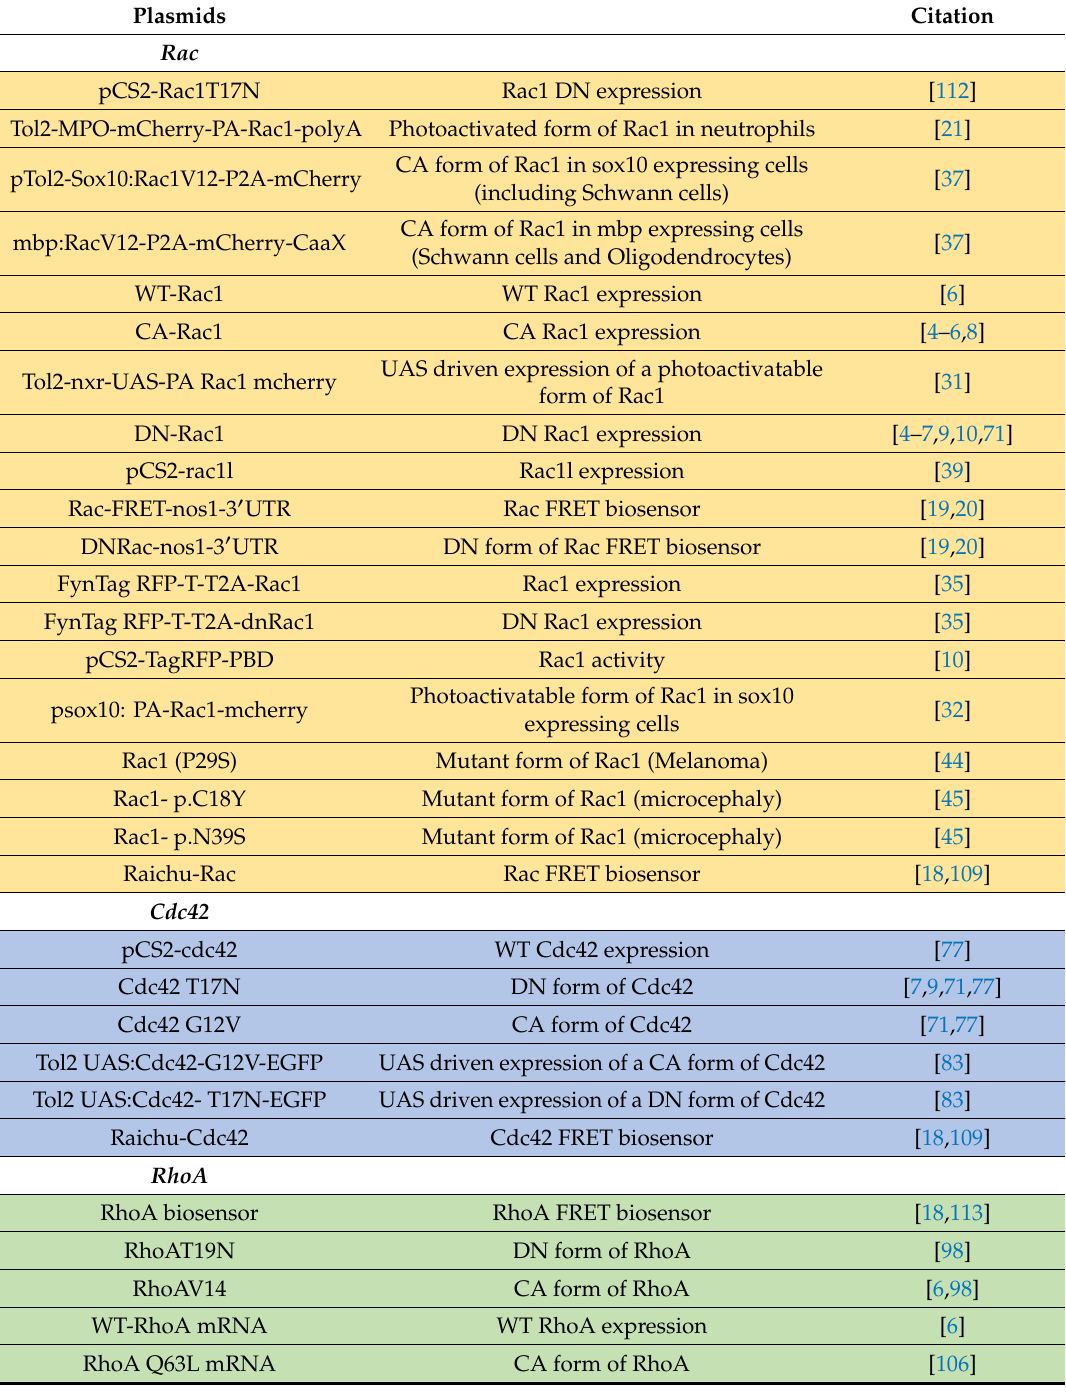
Table 2. Available constructs to study Rho GTPases in